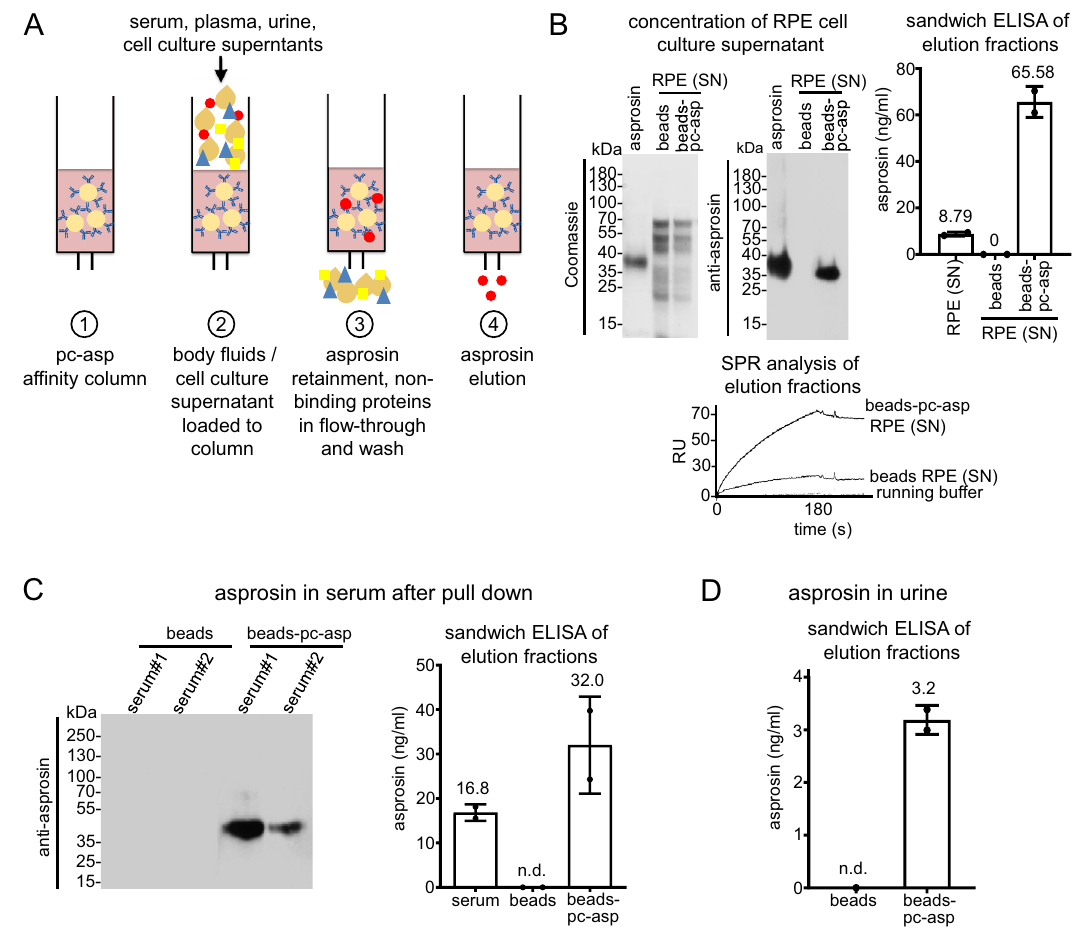
Figure 3. Affinity column chromatography allows specific asprosin concentration from serum and urine. ( A ) Schematic diagram showing the pull-down approach using pc-asp antibody for asprosin enrichment in cell culture supernatant and human biological samples. ( B ) (top left) Coomassie stain of 10% SDS-PAGE gel of recombinantly expressed and affinity-purified asprosin, pull-down from RPE media supernatant with CNBr beads (control), and pc-asp antibody coupled to CNBr beads. (top middle) Western Blot with mab anti-asprosin (1:1000, 1 µg/ml) showing specific bands of the recombinantly expressed asprosin and the endogenous asprosin of the RPE supernatant (1 L serum-free cell culture supernatant) pull-down from pc-asp antibody coupled to CNBr beads. (top right) Detection of asprosin in RPE cell culture media before and after pull-down enrichment showing an eight-fold increase of asprosin concentration by sandwich ELISA. (Bottom) Sensorgram of SPR showing detection of endogenous asprosin in RPE supernatant pull-down from CNBr beads coupled to the pc-asp antibody. Data obtained from two independent pull-down experiments. ( C ) (left) Western Blot analysis with mab anti-asprosin (1:1000 dilution, 1 µg/ml) of the pull-down from two human serum samples with pc-asp antibody coupled to CNBr beads showing endogenous asprosin band. (right) Quantification of the endogenous asprosin levels using sandwich ELISA in the human serum sample (1 ml serum diluted 1:10 with 10 mM Tris–HCl, pH 7.5) before and after enrichment of asprosin concentration by asprosin pull-down approach. ( D ) Detection of asprosin in human urine (200 ml) after enrichment using the pull-down approach. Data obtained from urine sample subjected to two independent pull- down experiments. Data were analyzed using Graphpad Prism version